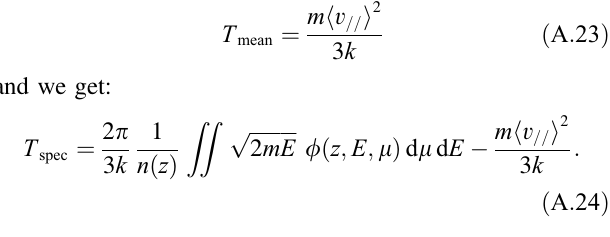
Fig. A.1. Usual cylindric coordinates. The electron follows a spiral around the magnetic fi eld, taken as the z axis. The projection of itsvelocityonthisaxisis v || .Theprojectionontheperpendicularplaneis v \